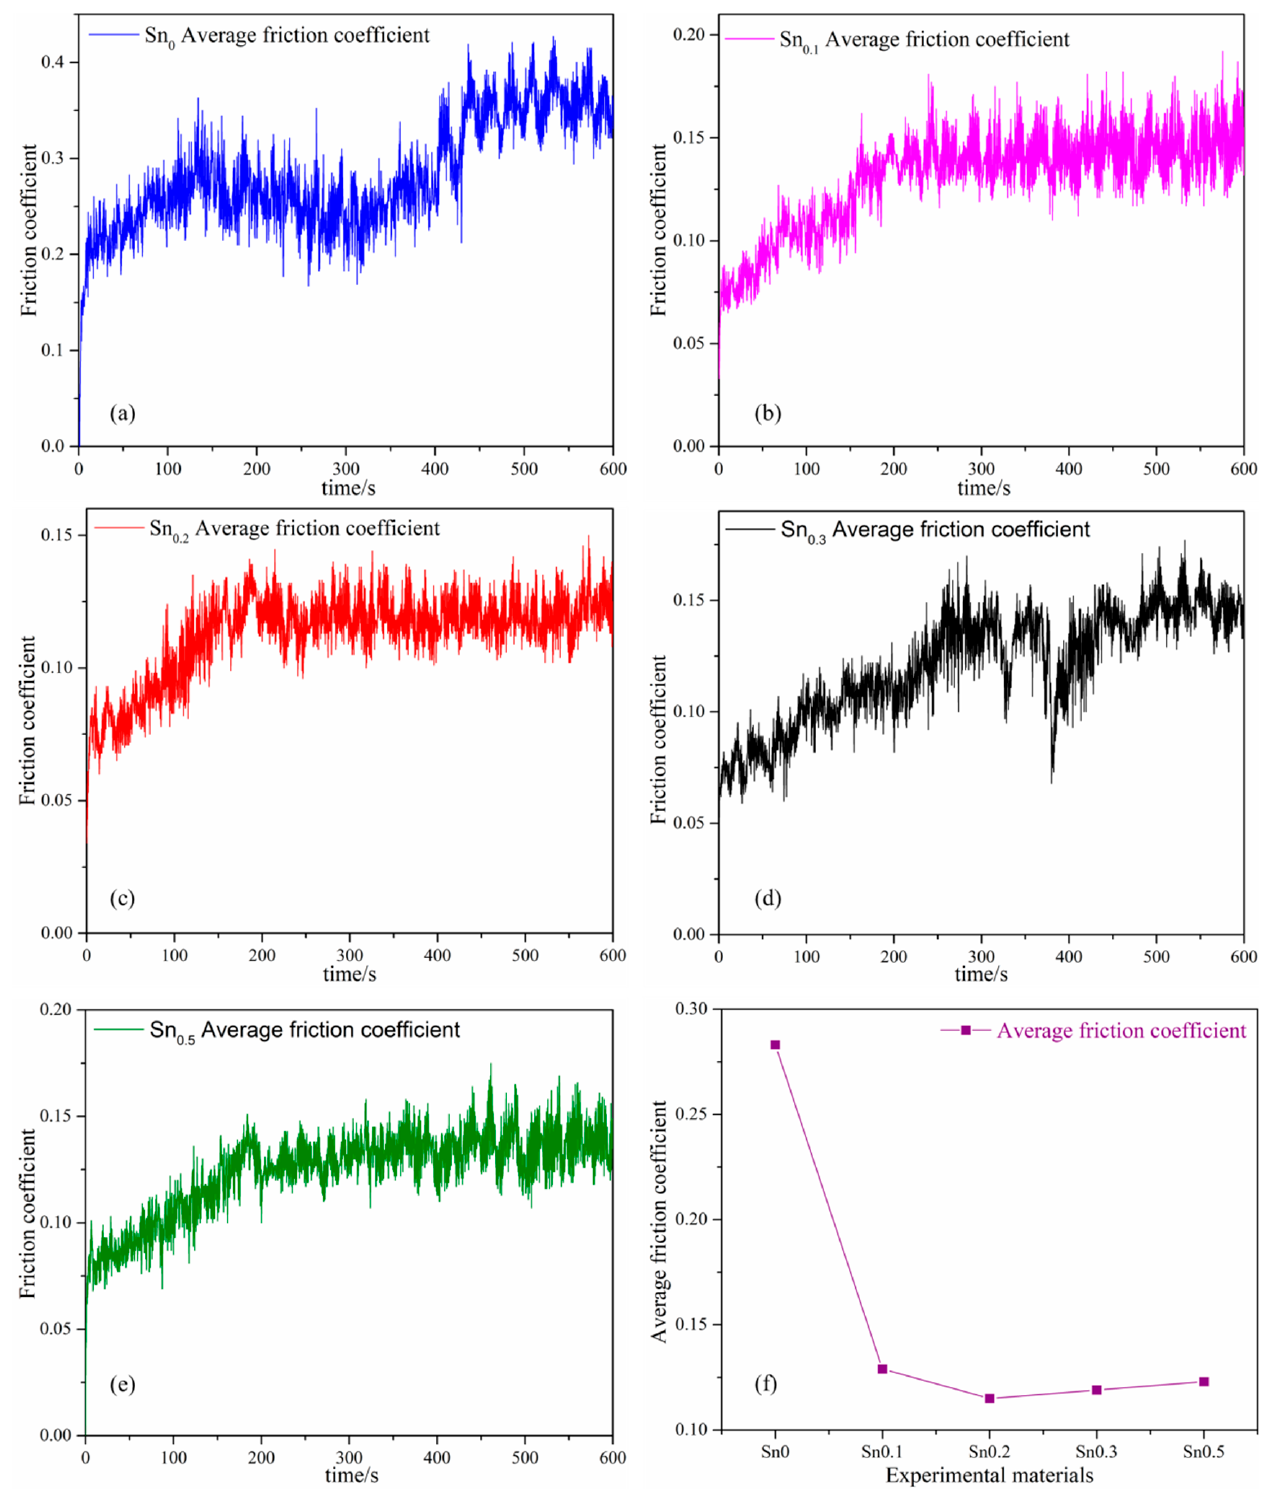
Figure 12. Variation curve of average friction coefficients of CoCrFeNiMnSn x HEAs ( a ) Sn 0 , ( b ) Sn 0.1 , ( c) Sn 0.2 , ( d ) Sn 0.3 , ( e ) Sn 0.5 , ( f ) fircion cofficient.